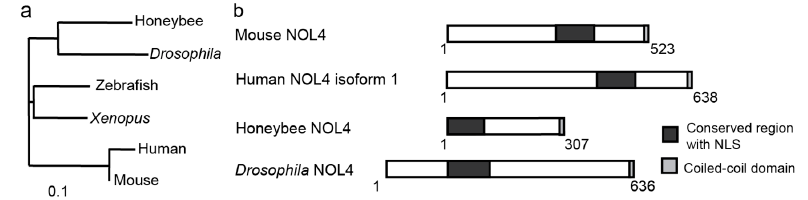
Figure 3. A conserved protein NOL4 has multiple splicing variants that differentially regulate the transcription activities of Mlr1 and Mlr2. ( a ) A phylogenetic tree of NOL4 family proteins. Generated by ClustalX2 using the neighbor-joining method; ( b ) Structures of NOL4 family proteins. Conserved regions with NLS and the coiled-coil domain are designated. Adapted with permission from [23].